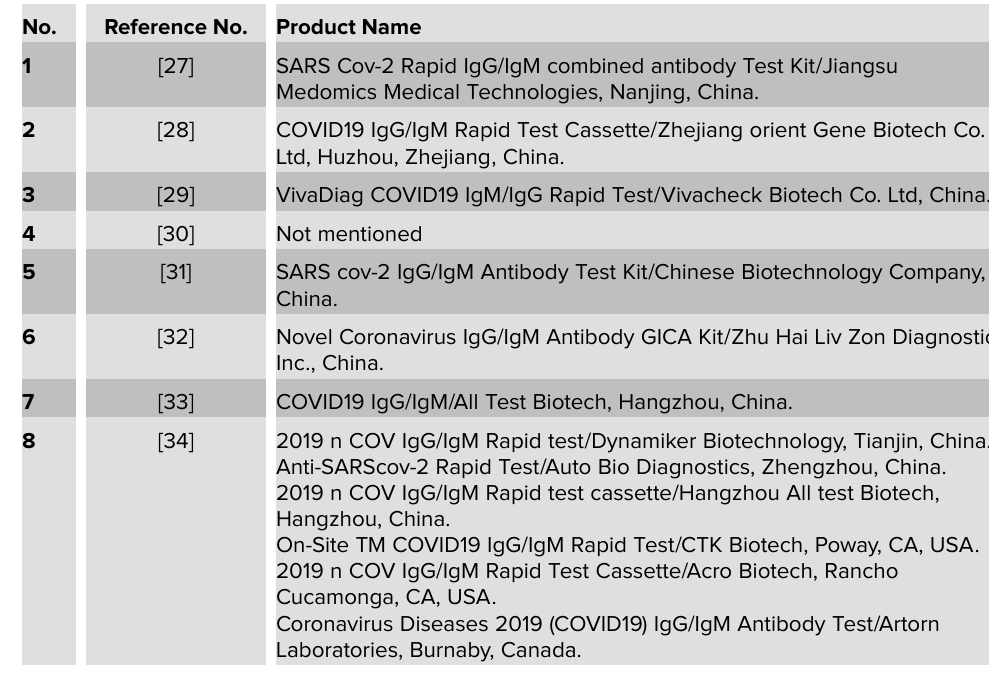
TABLE 2: Manufacturer information of IgM/IgG rapid